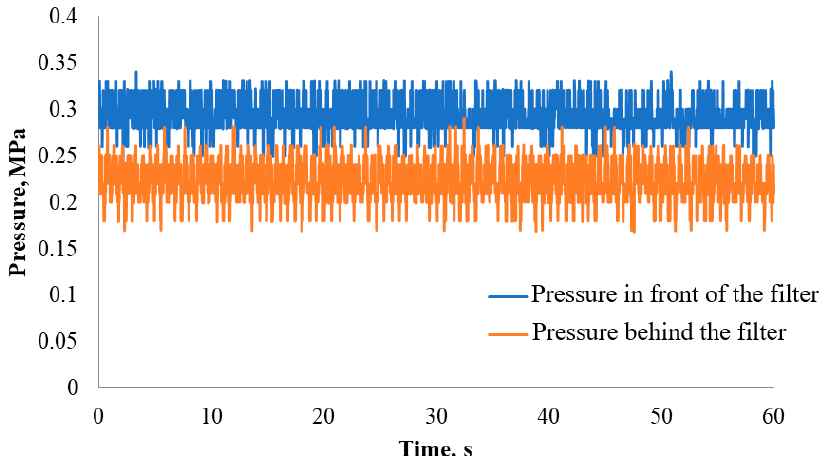
Figure 7. Plot of pressure of contaminated oil with MANN W950/26 filter at 30 °C.